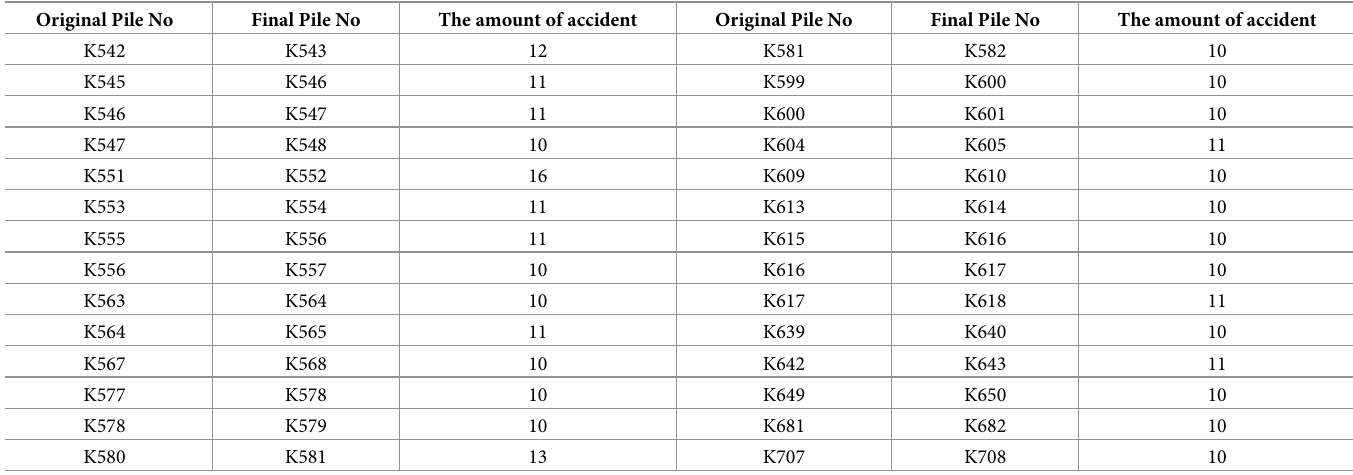
4.1.4 The calculation of accident probability of black spots. After considering the actual situation of every freeway, i.e., the traffic flow and the total number of accidents on every free- way, we calculate the probability of accident at black spot that is just a relative value. The method is expressed as follows.